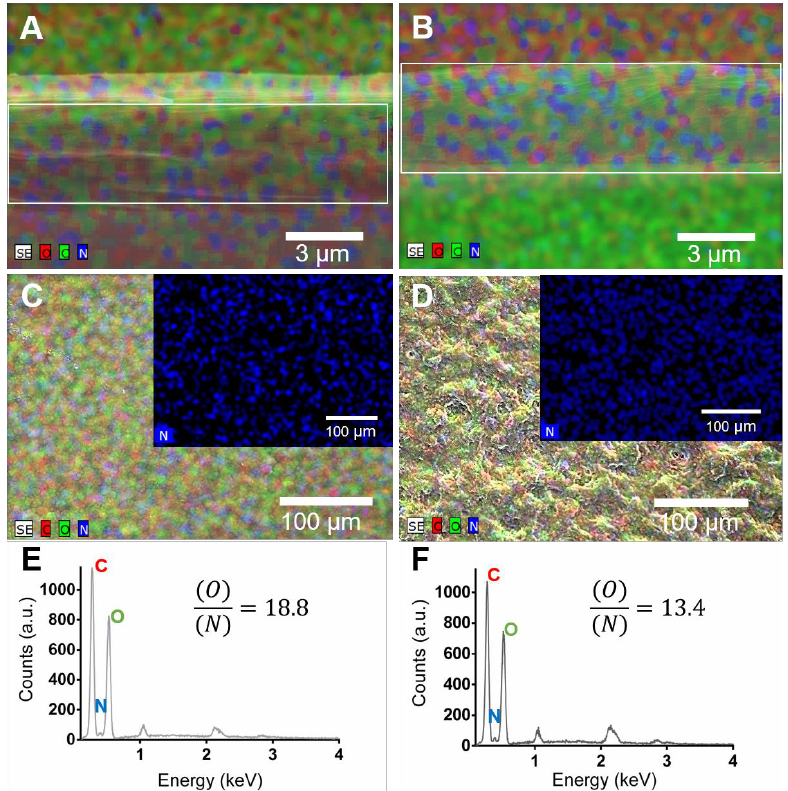
Figure 5. Mixed element map for carbon (C), oxygen (O) and nitrogen (N) of the cross-section of ( A ) [CHT/HA] 200 and ( B ) [CHT/HA-DN] 200 freestanding membranes. Mixed element map for carbon (C), oxygen (O), and nitrogen (N) of upper surface of ( C ) [CHT/HA] 200 and ( D ) [CHT/HA-DN] 200 freestanding membranes. Energy-dispersive X-ray spectra and ration quantification of O/N of ( E ) [CHT/HA] 200 and ( F ) [CHT/HA-DN] 200 freestanding membranes. a.u.: Arbitrary units.